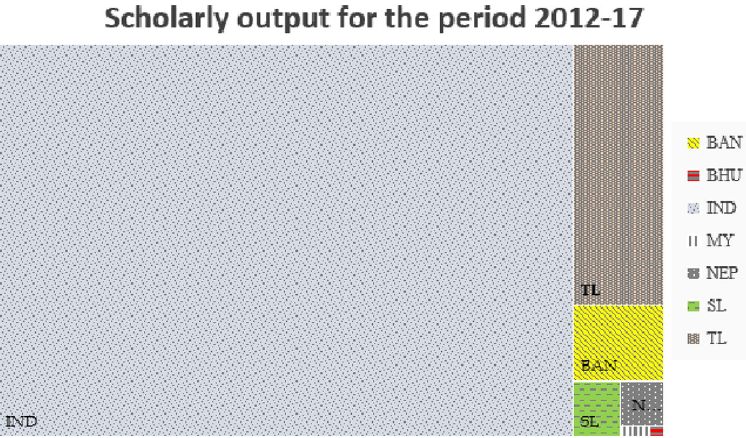
Figure4.TreemaprepresentationofscholarlyoutputofBIMSTECcountries. India(IND),Thailand(TL),Bangladesh (BAN), Sri Lanka (SL), Nepal (NEP), Myanmar (MY), Bhutan (BHU).